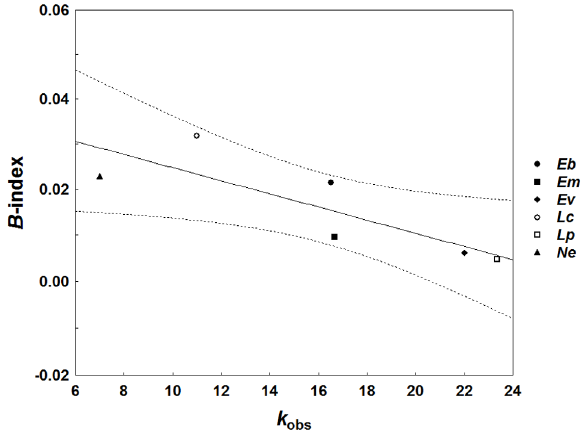
Figure 2. Association of mean paternity skew ( B -index) and mean observed paternity frequencies ( k obs ) across six Neo- tropical army ant species (represented by different symbols). The solid line indicates the slope of a phylogenetically corrected GLS regression ( b =–0.001, R 2 =0.74, p =0.008) and dashed lines the 95% confidence interval.